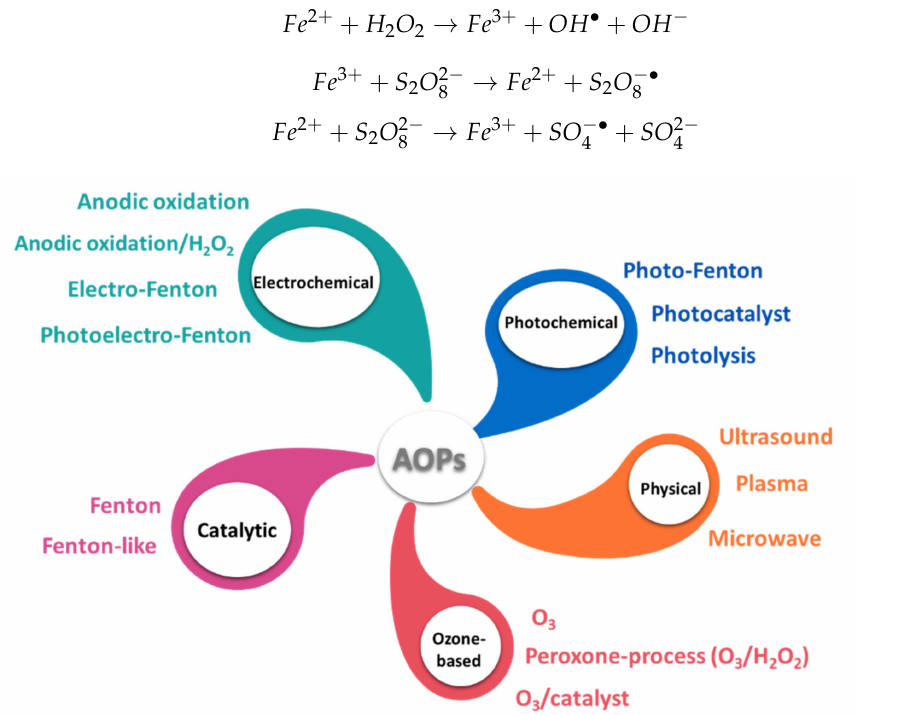
Figure 6. Classification of AOP by the fundamentals of the process